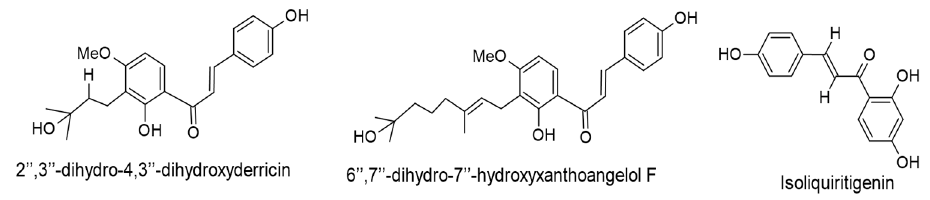
Figure 8. Chemical structures of chalcones with therapeutic effects against EBV-correlated cancers.